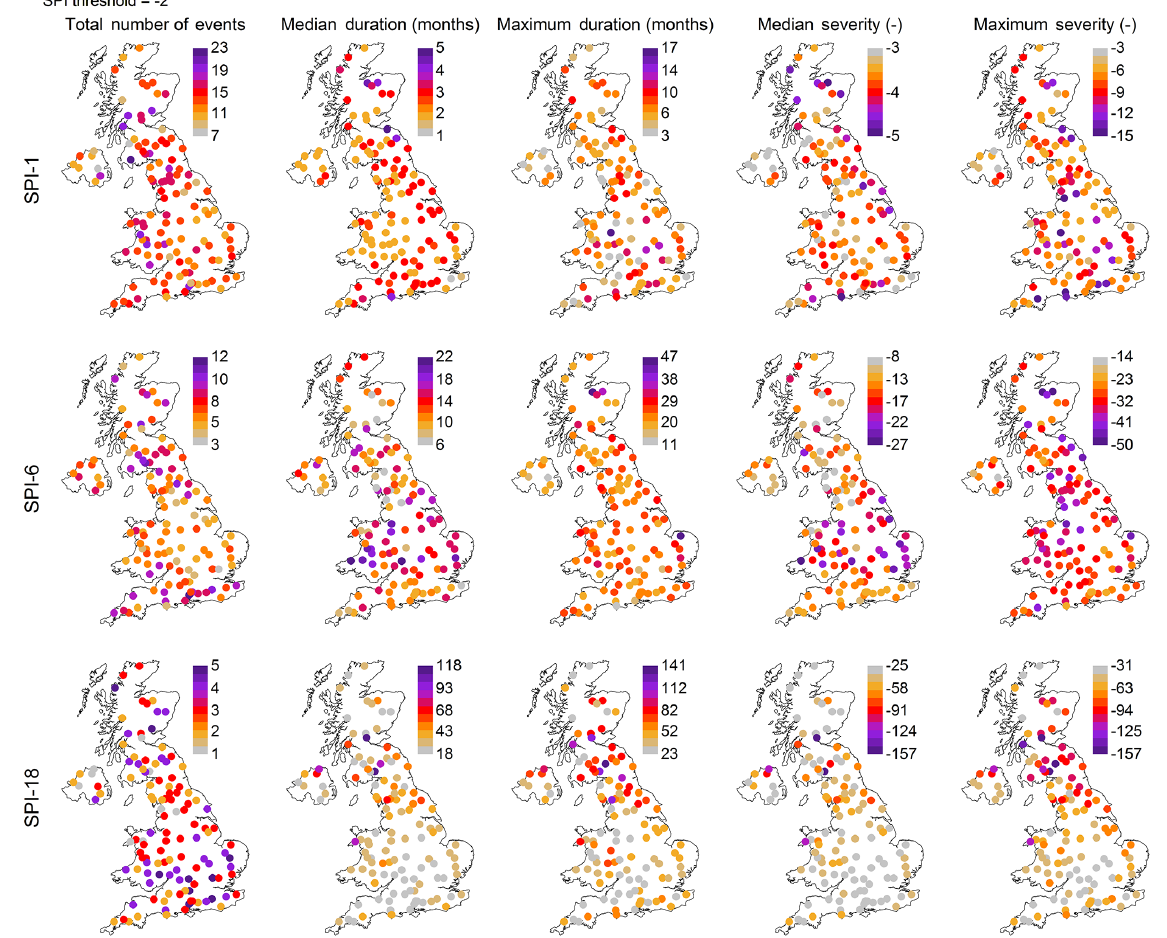
Figure 3. Maps showing selected meteorological drought characteristics based on SPI-1, SPI-6 and SPI-18 using a threshold of − 2. Note that the colour scale is different for each accumulation period to best show the spatial variability of the